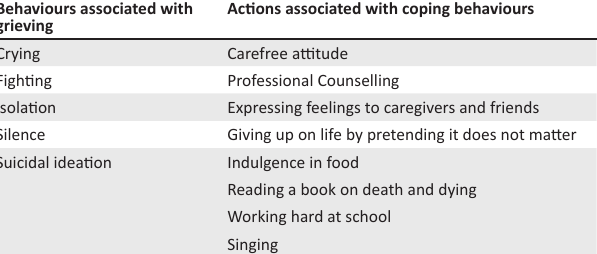
TABLE 3: Grieving and coping patterns used by adolescents orphaned by